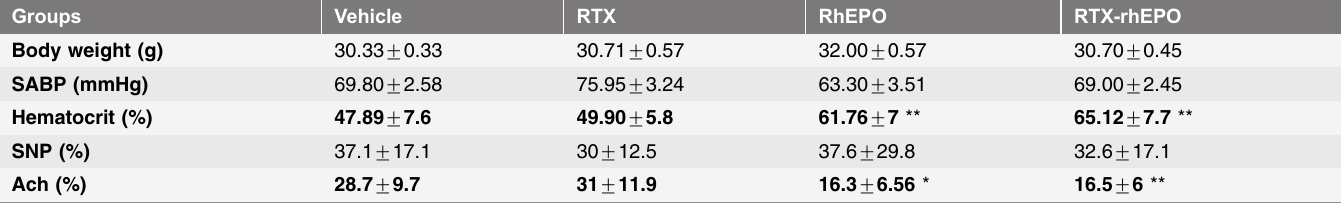
Table 1. Effect of RTX and rhEPO on body weight, SABP, hematocrit and skin microvascular reactivity. Groups